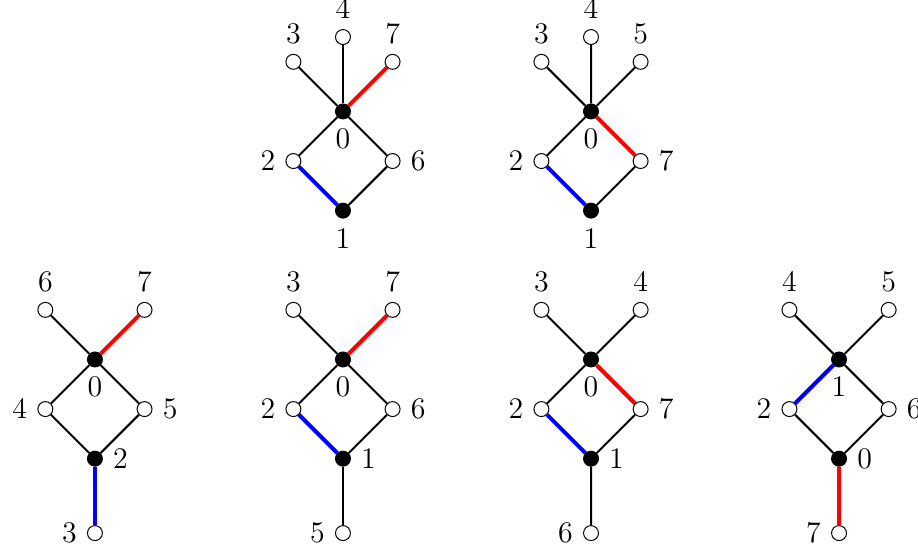
Figure 4: Complete set of α -labelings for two unicyclic graphs of size